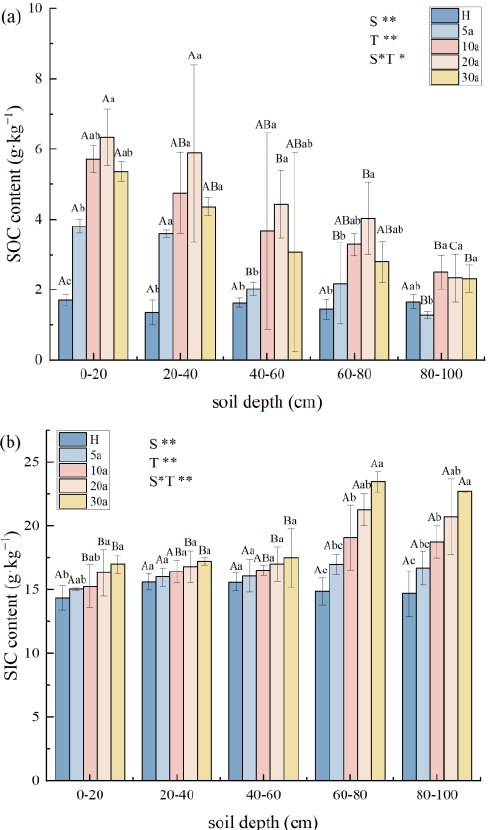
Figure 2. Profile distribution characteristics of soil SOC ( a ) and SIC ( b ) contents in cotton fields with different years of continuous cropping. Note: Different capital letters indicate significant differences between different soil depths in the same continuous cropping years, and different lowercase letters indicate significant differences between different continuous cropping years at the same soil depth; S indicates the main effect of different continuous cropping years, T indicates the main effect of different soil layers, and S*T indicates the interaction effect of different continuous cropping years and different soil layers; ** indicates a highly significant correlation ( p < 0.01), and * indicates a significant correlation ( p < 0.05).